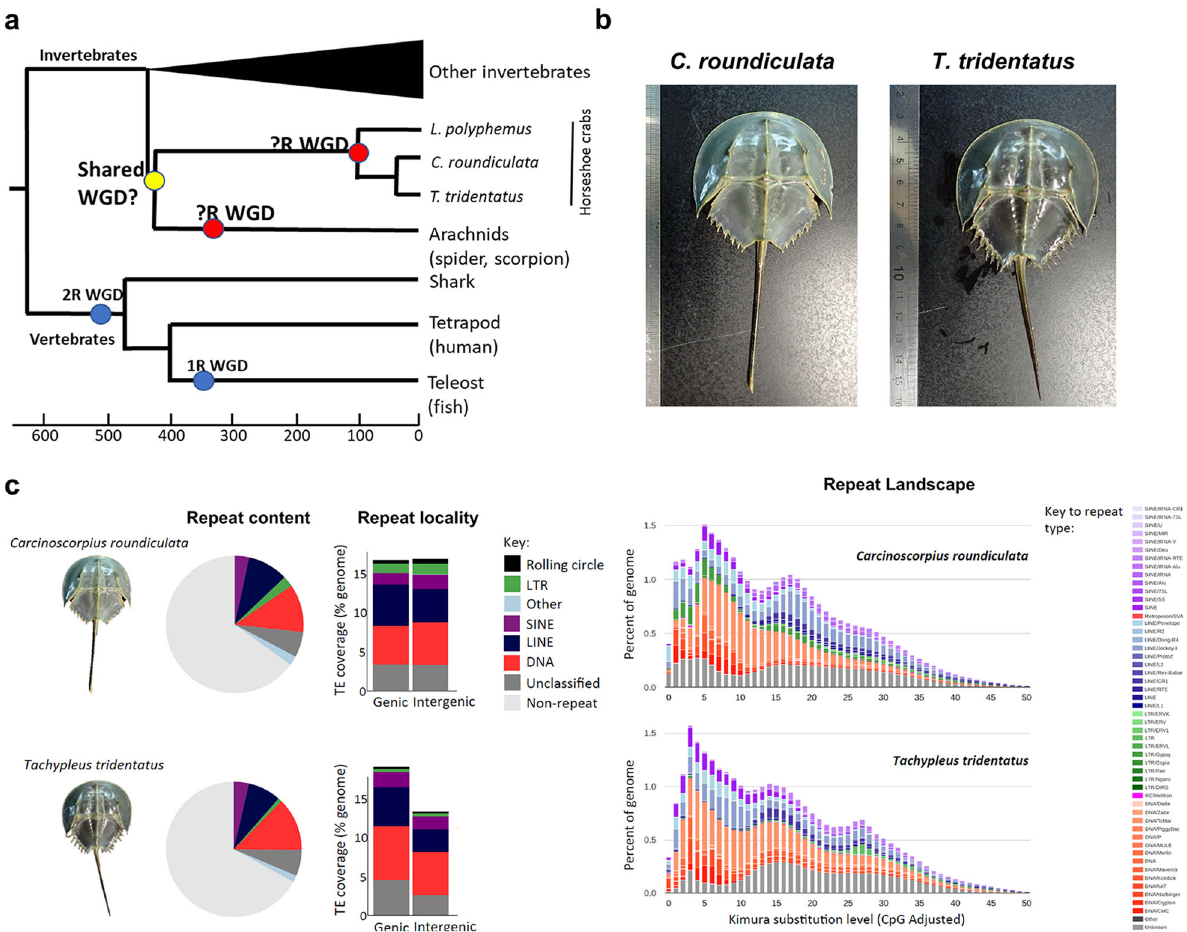
Fig. 1 Horseshoe crabs C. roundicultata and T. tridentatus . a Schematic diagram illustrating the current knowledge of whole-genome duplication (WGD) in animals. ‘ ?R ’ denotes unknown rounds of whole-genome duplication; b pictures of horseshoe crabs C. roundicultata and T. tridentatus ; c Repeat content for the two horseshoe crab genomes, C. rotundicauda and T. tridentatus : Pie charts illustrating repeat content as a proportion of total genomic content; Repeat content present in genic verses intergenic regions; and Repeat landscape plots illustrating transposable element activity in each horseshoe crab genome. Source data reveals these fi gures can be found in Supplementary Data